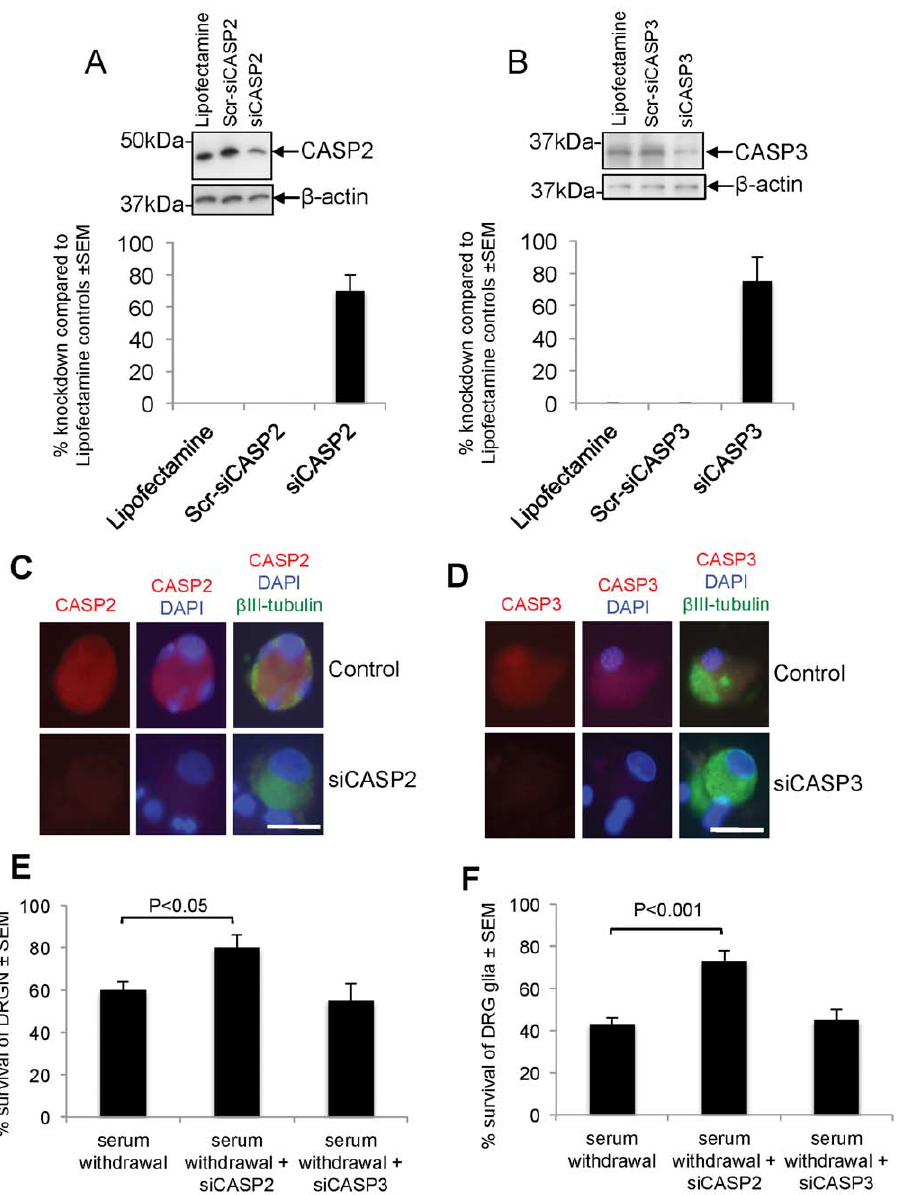
Figure 8. CASP2 knockdown protects DRGN and DRG glia from apoptosis induced by serum withdrawal. A , Western blot and B , subsequent densitometry to show CASP2 and CASP3 protein levels after knockdown with relevant siRNA. C , and D , Immunocytochemistry to demonstrate CASP2 and CASP3 knockdown in DRGN and satellite cells by relevant siRNA, respectively. E , Quantification of DRGN and F , DRG glia survival after siRNA-mediated knockdown of CASP2 and CASP3. Scale bars in C and D =50 m